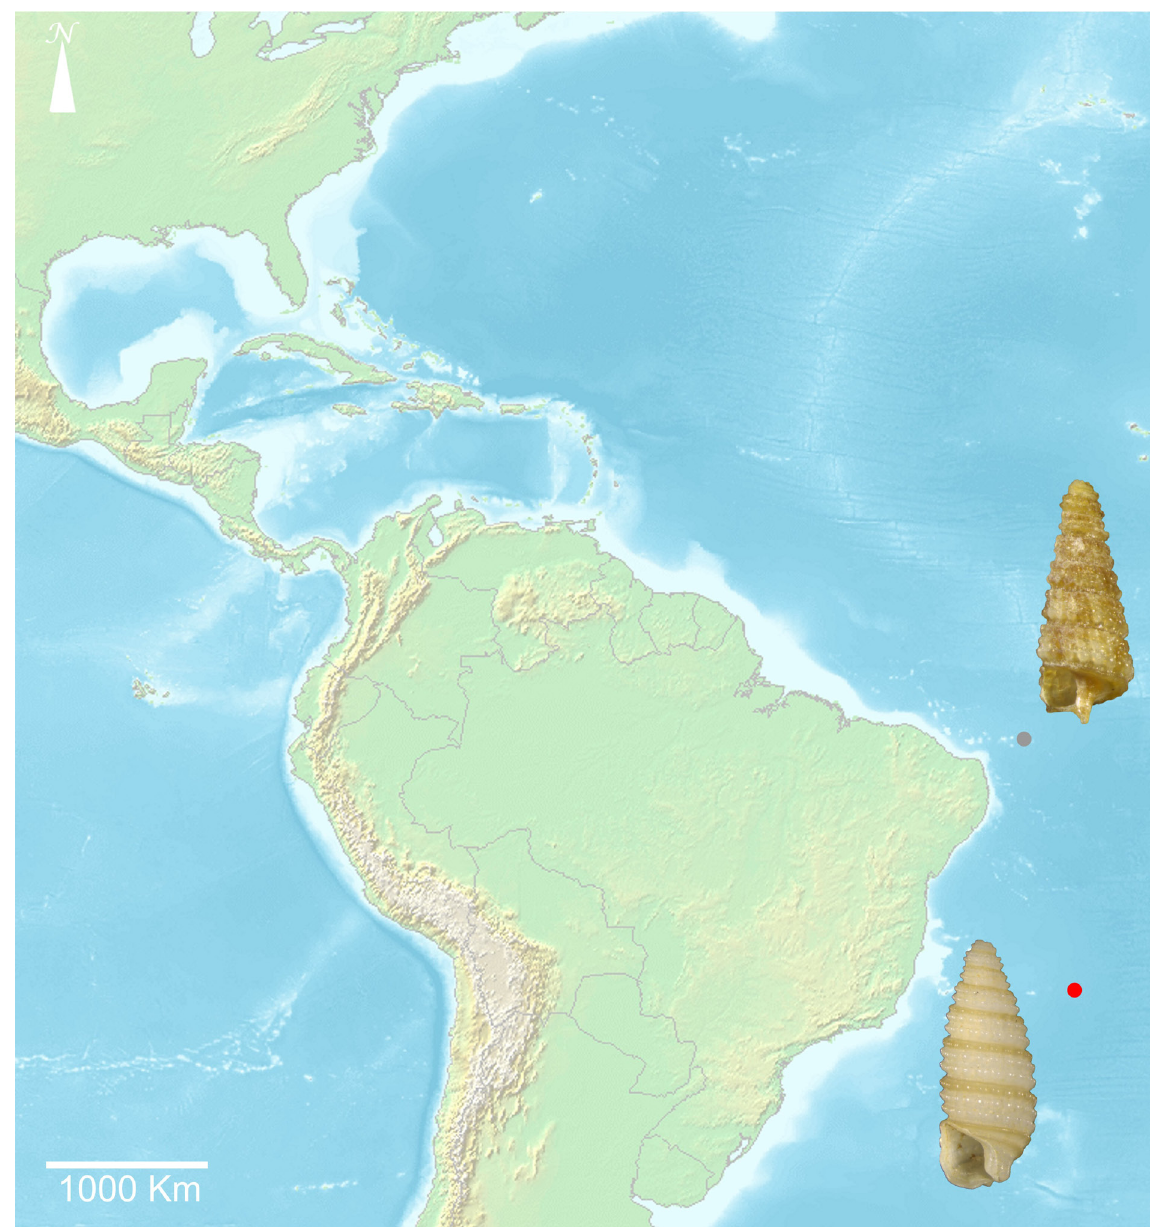
Fig. 52. Distribution map of Isotriphora sp. 1 (gray circle) and Isotriphora leo sp. nov. (red